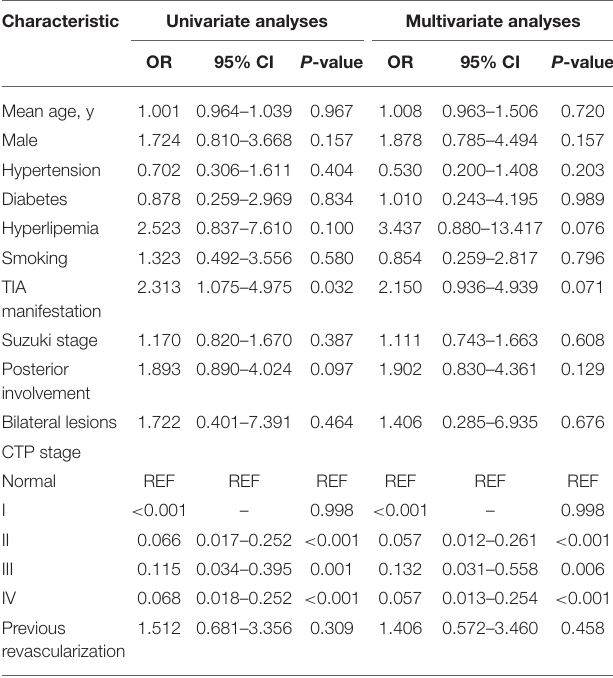
TABLE 2 | Logistic regression analysis for hemorrhagic transformation in adult ischemic